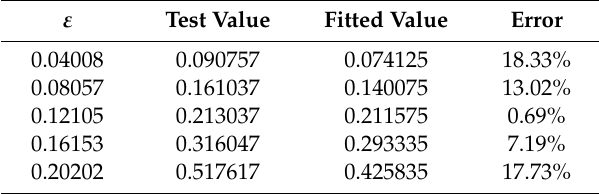
Table 5. The deviation between the tested stress and the fitted stress for specimen 1 under 200 ◦ C. ε Test Value